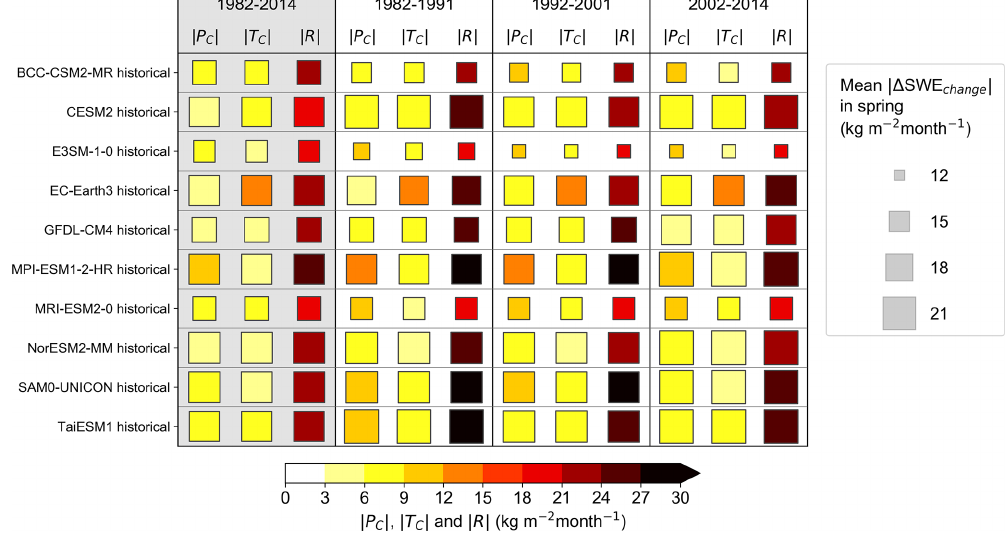
Figure 11. The areal means of absolute values of (cid:49) SWE change , P C , T C , and residual R calculated for the entire study period 1982–2014 (left column, shaded with grey) and for three shorter time periods (1982–1991, 1992–2001, and 2002–2014) for each model in spring. The size of the square indicates the mean absolute value of (cid:49) SWE change of that time period and model, and the color of the square indicates the mean absolute value of P C , T C , and R